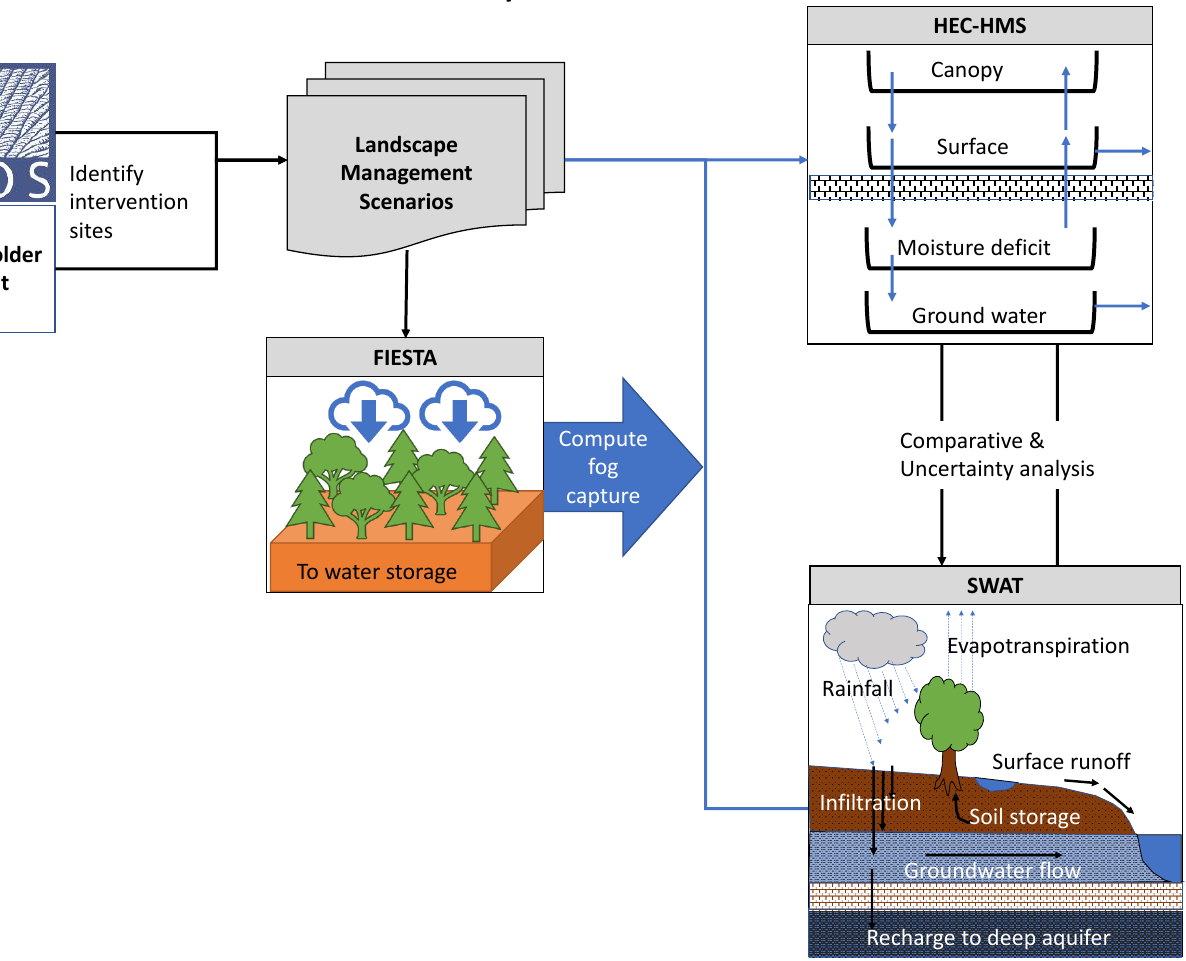
Figure 7. Multi-model synthesis framework illustrates model integration from identification of intervention sites, computation of fog capture potential for each NbS scenario, and simulation of the scenarios using two comparative hydrologic simulation models.